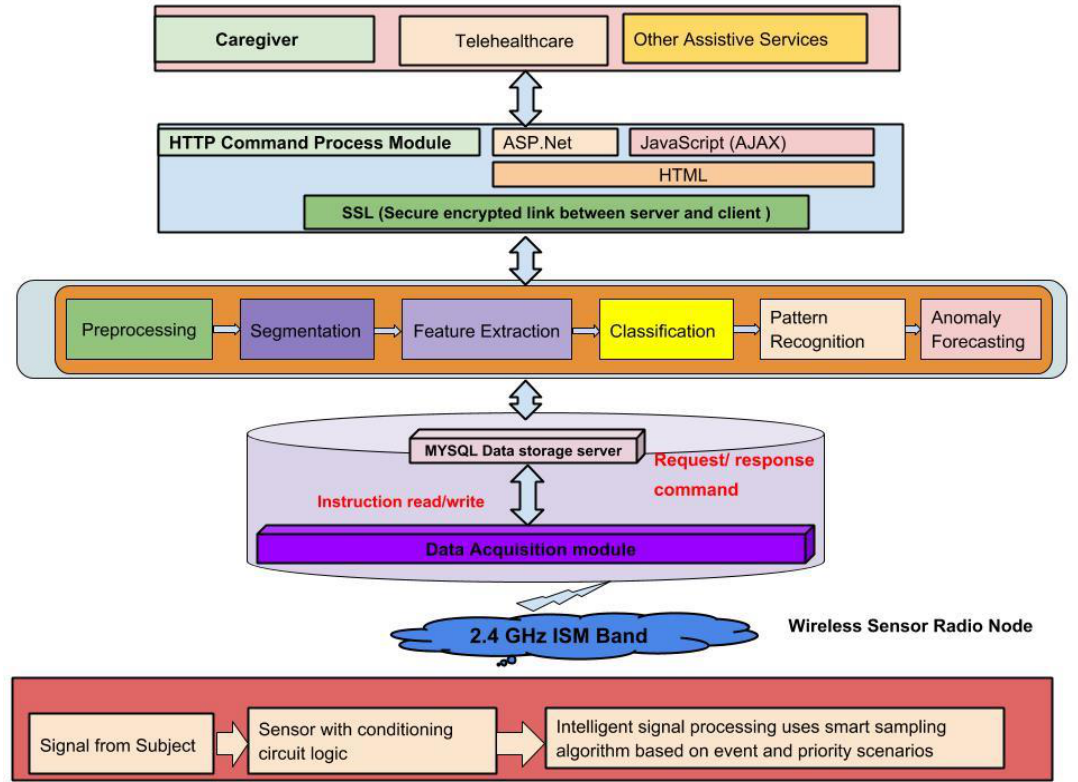
Figure 1. The bottom-up diagram to represent the Smart Home-based AAL system.